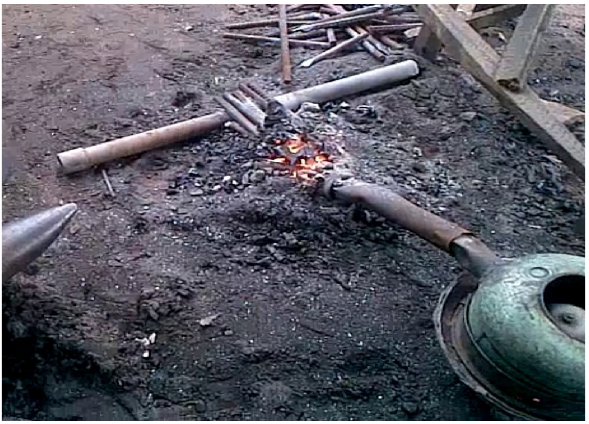
Figure 9 | Hammering a red-hot steel rod to form a spike. Photograph by Kingsley O. Emeriewen,